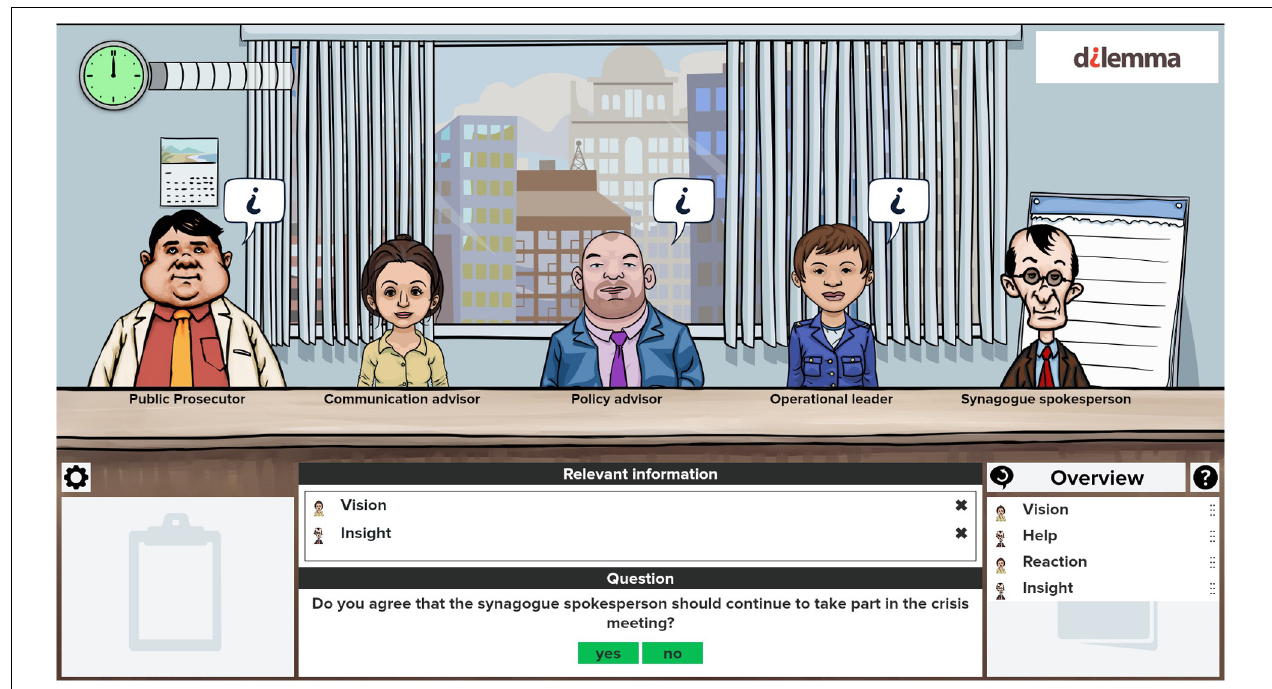
FIGURE 1 | Screenshot of dilemma